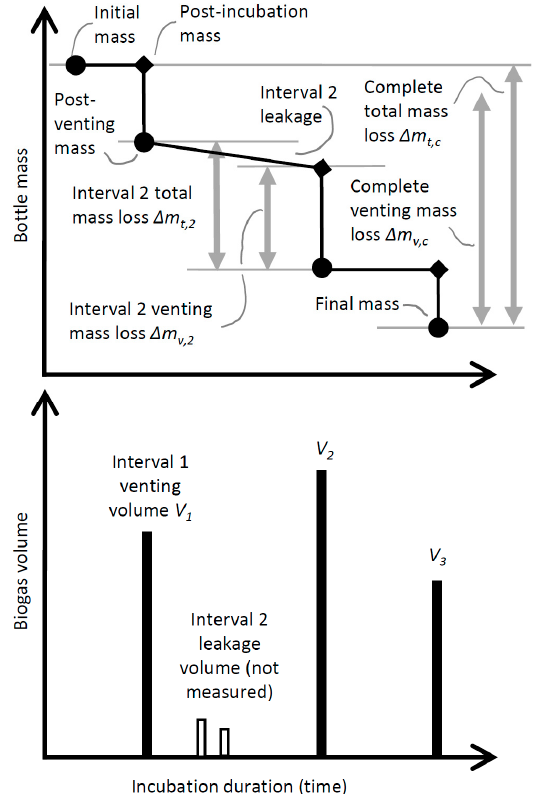
Figure 2. A graphical representation of GD-BMP measurements showing measurements for only three measurement intervals (a typical BMP experiment will have more). The top panel shows mass measurements, and the bottom shows biogas volume measurements made from the same hypothetical bottle over the same intervals. Note that total mass loss and venting mass loss differ only if leakage occurs (in addition to differences due to measurement errors). In this example, leakage occurred during the second interval. Complete total mass loss does not contain all measurement errors that are present in interval total mass loss. Excluding error in initial and final mass measurements, measurement errors exactly cancel or compensate (i.e., the sum of all interval total mass loss measurements is exactly equal to the difference between initial and final mass).